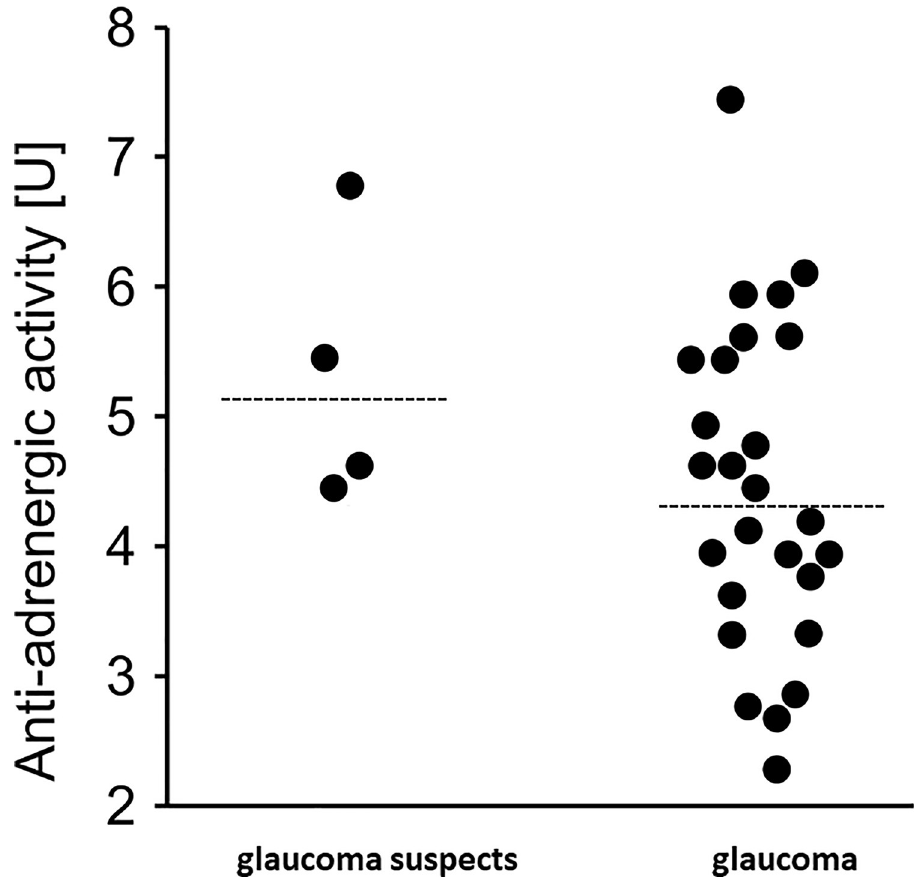
Fig 3. Anti-adrenergic activity β 2-agAAb [U] subdivided in glaucoma suspects and glaucoma patients (raw data; median).